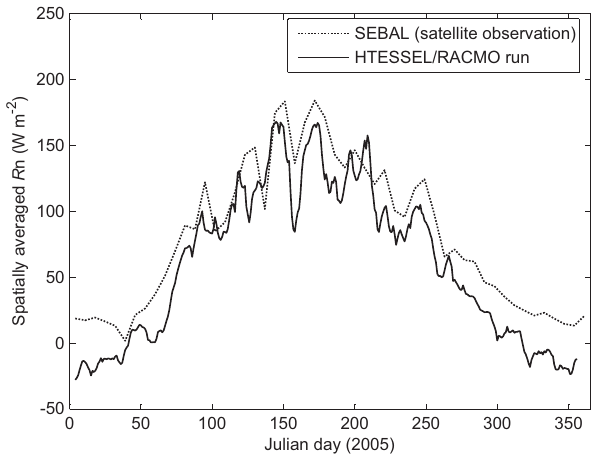
n over 2005, as ob- tained by the SEBAL algorithm and from the HTESSEL/RACMO simulation, respectively, being averaged over the test area. The meteorological forcing and initial conditions were obtained from a one-year RACMO2-hindcast run driven by ECMWF operational